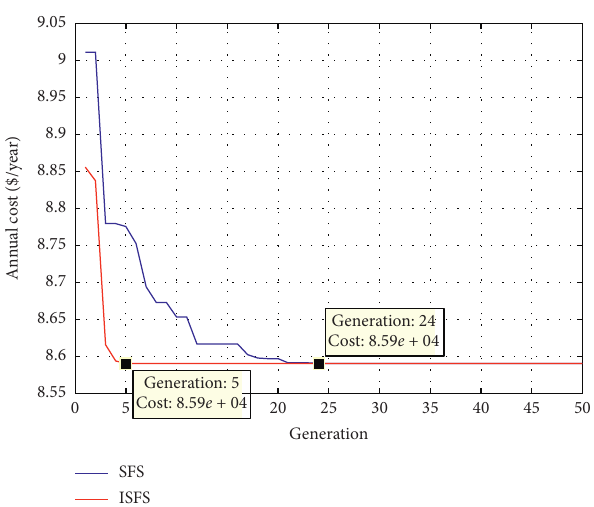
Figure 9: Convergence characteristics of annual cost for 69-bus network with 100% loading in scenario 1.